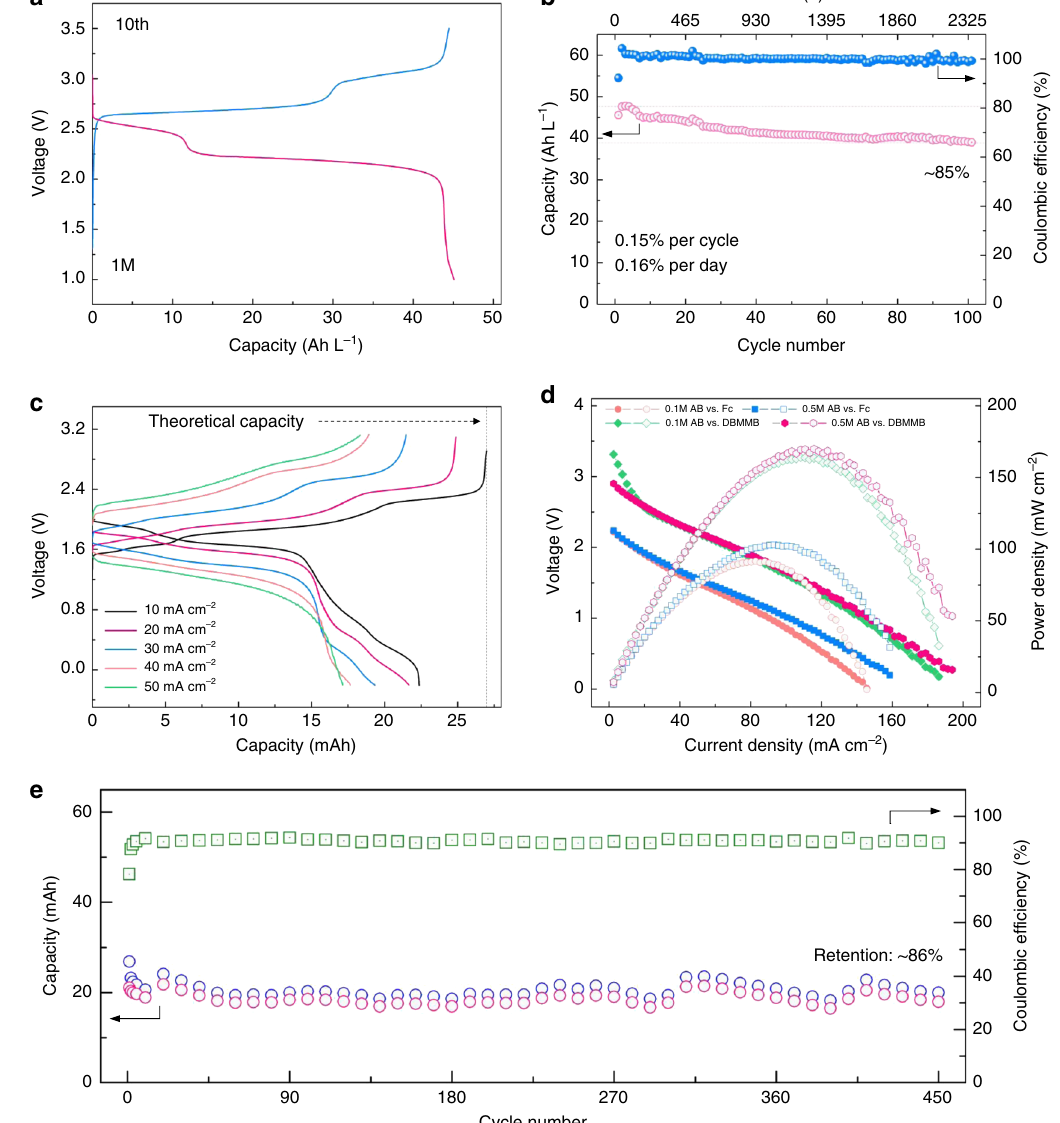
Fig. 4 Cycling stability at high concentrations and fl ow battery test. Representative voltage pro fi le of AB electrolyte (1 M) at the speci fi c cycle at the current density of 0.2 mA cm − 2 ( a ) and corresponding cycling capacity and coulombic ef fi ciency of 1 M AB electrolyte ( b ). c Charge and discharge pro fi les of 0.1 M AB/Fc fl ow cell at current densities varied from 10 to 50 mA cm − 2 . d Polarization curves and power density of 0.1 and 0.5 M AB/Fc or AB/ DBMMB fl ow cells. e Cycling capacity and coulombic ef fi ciency of the 0.1 M AB/Fc fl ow cell using mixed electrolytes cycled at 25 mA cm − 2